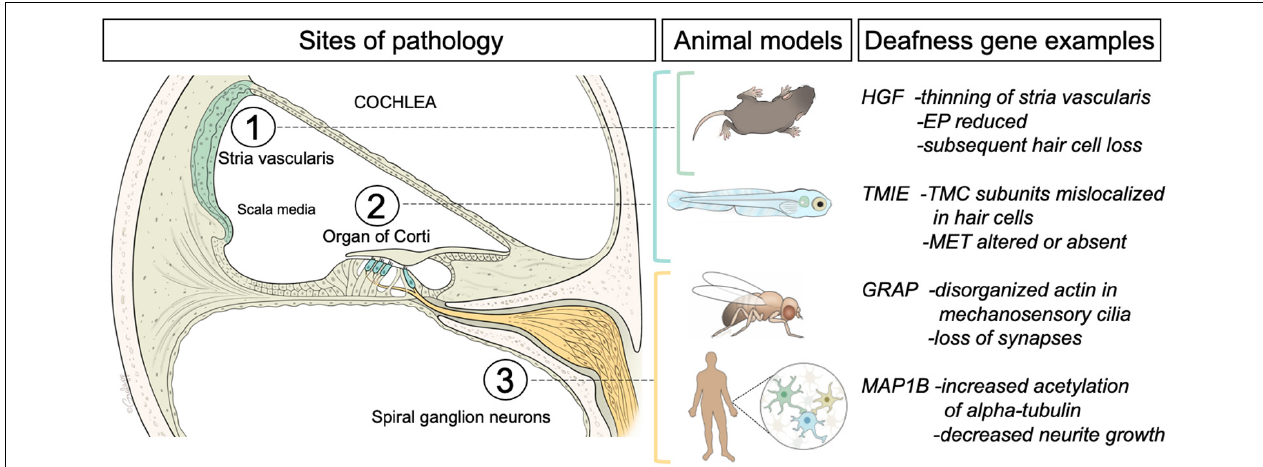
FIGURE 1 | Left panel, schematic of a cross sectional view of the cochlea, the hearing organ of the inner ear. The three regions of interest for this review are indicated. The fluid-filled middle compartment (scala media) contains the stria vascularis, a multilayer of cells (green) that generates the high concentration of potassium ions that are needed for sound detection. The neuroepithelium (organ of Corti) is comprised of sensory hair cells (inner and outer hair cells indicated in blue) embedded in a layer of supporting cells. Auditory hair cells are innervated by afferent or spiral ganglion neurons (yellow) that project to the hindbrain. Middle panel indicates the animal and cell models ( Mus Musculus mice, Danio rerio zebrafish larvae, Drosophila flies, and human-derived cells) used for the studies of pathology induced by mutations in the orthologs of four different examples of human deafness genes (right panel). For a more comprehensive list of deafness genes please see the Hereditary Hearing Loss web site (https://hereditaryhearingloss.org/). A brief summary of the findings is included. EP, endocochlear potential; TMC, transmembrane channel-like; MET,